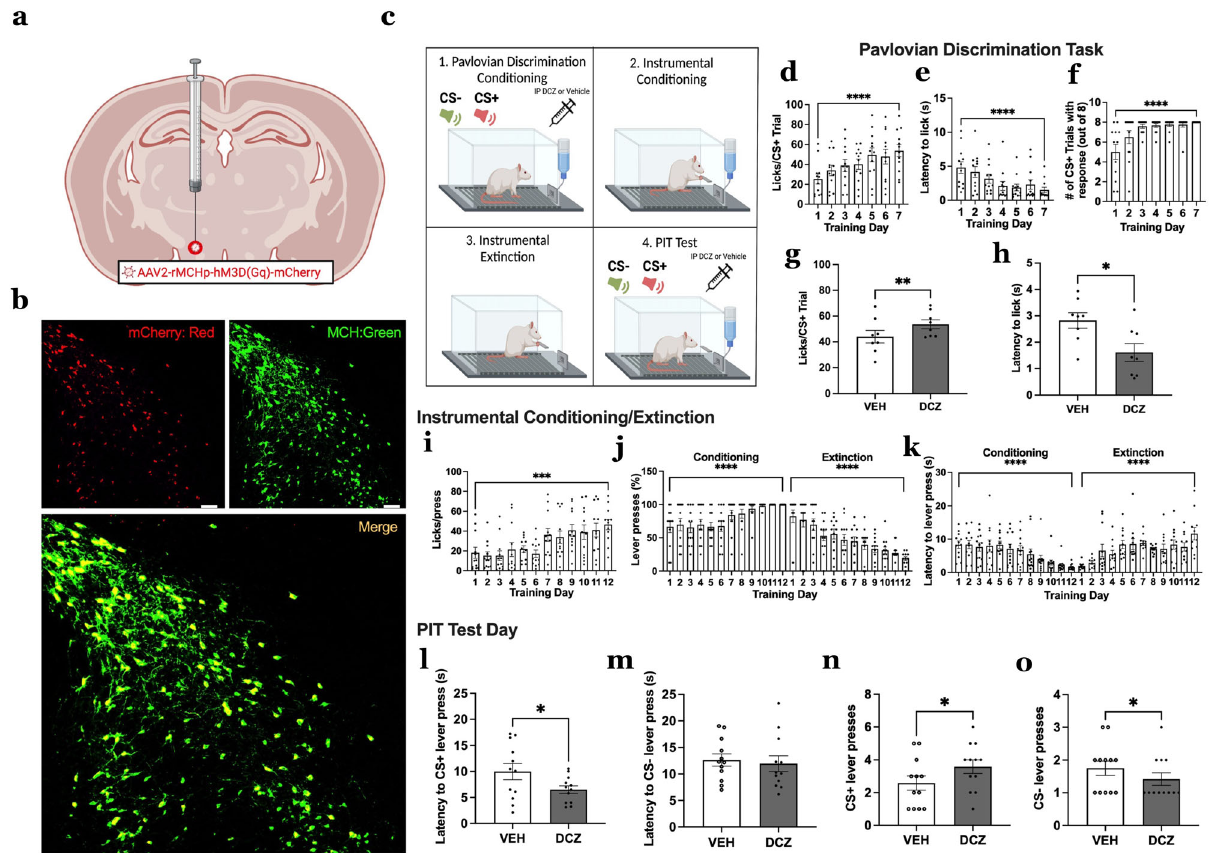
Fig.4|MCHneuronactivationincreasesappetitiveresponsestodiscretefood- predictive cues. a Schematic diagram depicting a viral approach to chemogen- etically activate MCH neurons. An adeno-associated-virus containing excitatory MCH DREADDs-mCherry transgene (AAV2-rMCHp-hM3D(Gq)-mCherry) is injected intotheLHA/ZI. b Representativeimagesof fl uorescentreporterinMCHDREADDs colocalizing with MCH immunoreactive neurons (repeated and veri fi ed indepen- dentlyin n =8rats) c SchematiccartoondepictingchemogeneticactivationofMCH neurons during Pavlovian-Instrumental-Transfer (PIT). d – f Training data for Pav- lovian discrimination task (data were analyzed using a one-way ANOVA with repeated measures and multiple comparisons, n =8 rats): d Average number of licks for sucrose solution per CS+ trial, e Average latency to lick from sucrose solutionperCS+trialand f averagenumberofCS+trialswitharesponsevialicking sucrose solution. g , h Effects of chemogenetic activation of MCH neurons during the test phase of Pavlovian discrimination task in rats (data analyzed using